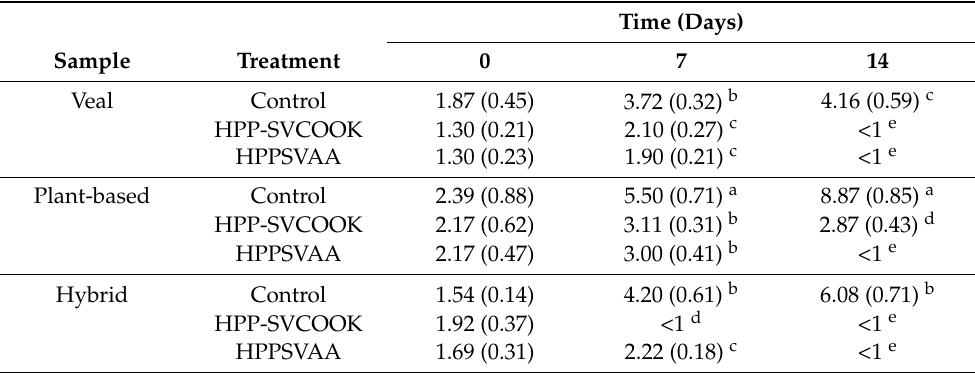
Table 7. Fungi and yeast counts (mean of log cfu/g (standard deviation)) in the veal, plant-based, and hybrid patty during the 0, 7, and 14 days after